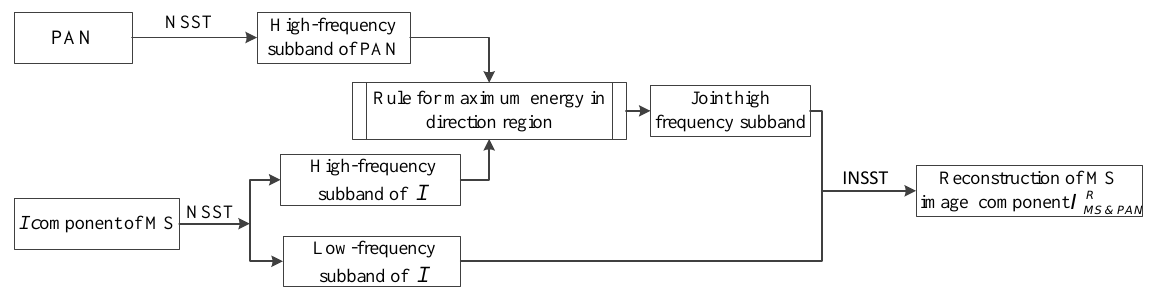
Figure 8. The flow chart of the reconstruction of MS image component I .